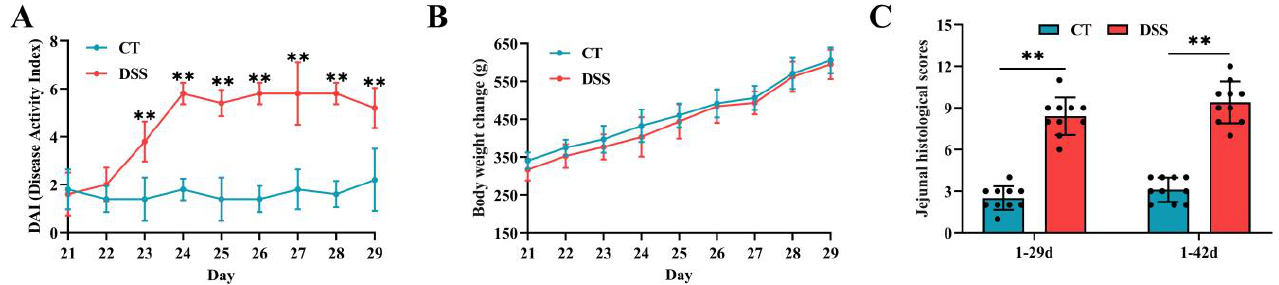
Figure 2. Effects of oral gavage of DSS on the signs of enteric inflammation in broilers: ( A ) DAI scores (n = 5 per group); ( B ) body weight changes (n = 5 per group); and ( C ) jejunal histology scores (n = 10 per group) at two different time points (1–29d and 1–42d). Values are means ± SD. ** p < 0.01. DAI: disease activity index.